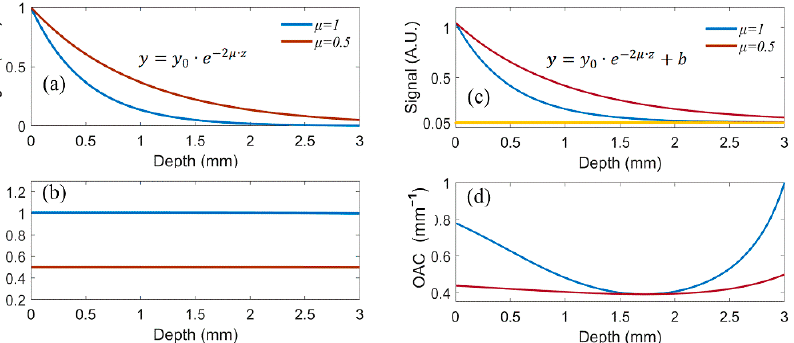
Figure 1. Two numerical simulations that feature exponential decay, with OACs set to 0.5 and 1, and in which the initial light intensity is 1; the attenuation models are y = y 0 · e − 2 µ · z ( a ) and y = y 0 · e − 2 µ · z + b ( c ), respectively, b = 0.05. ( b , d ) are the corresponding OACs obtained by using Equation